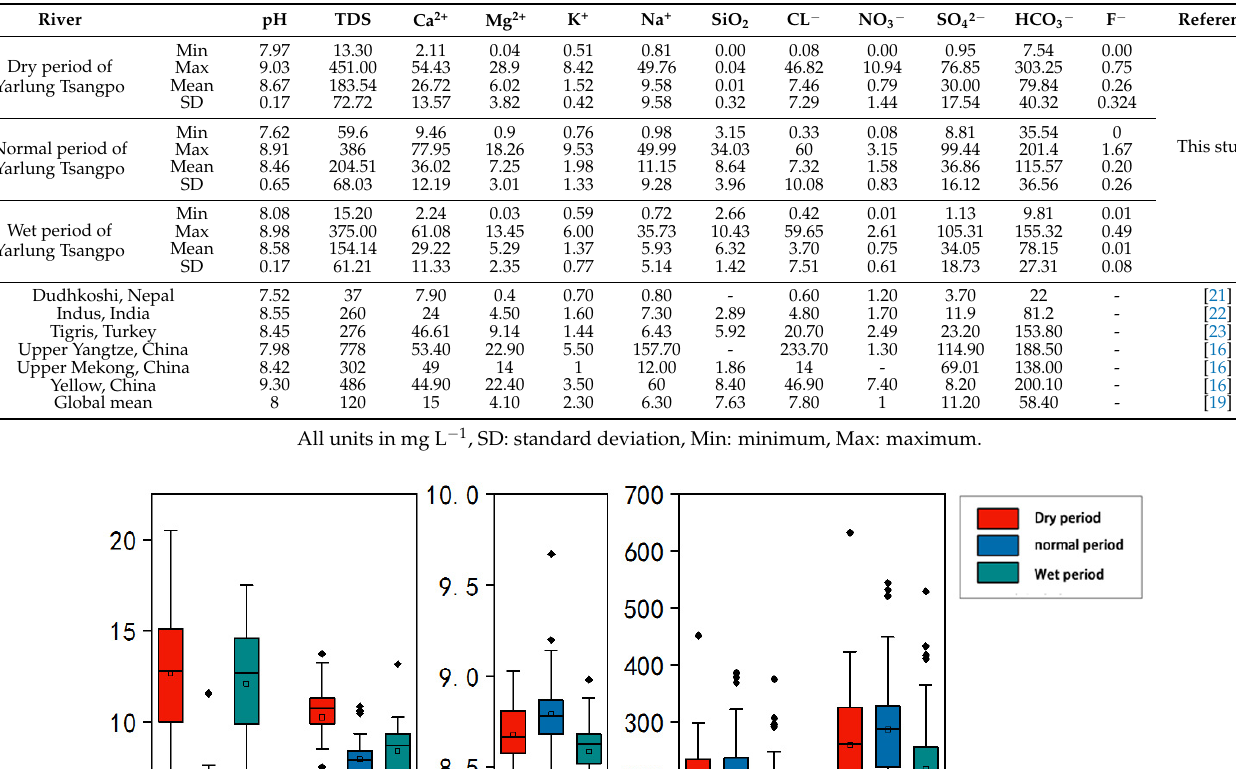
Table 1. Summary statistics of hydrochemical composition of the Yarlung Tsangpo and its comparison with other rivers around the world.